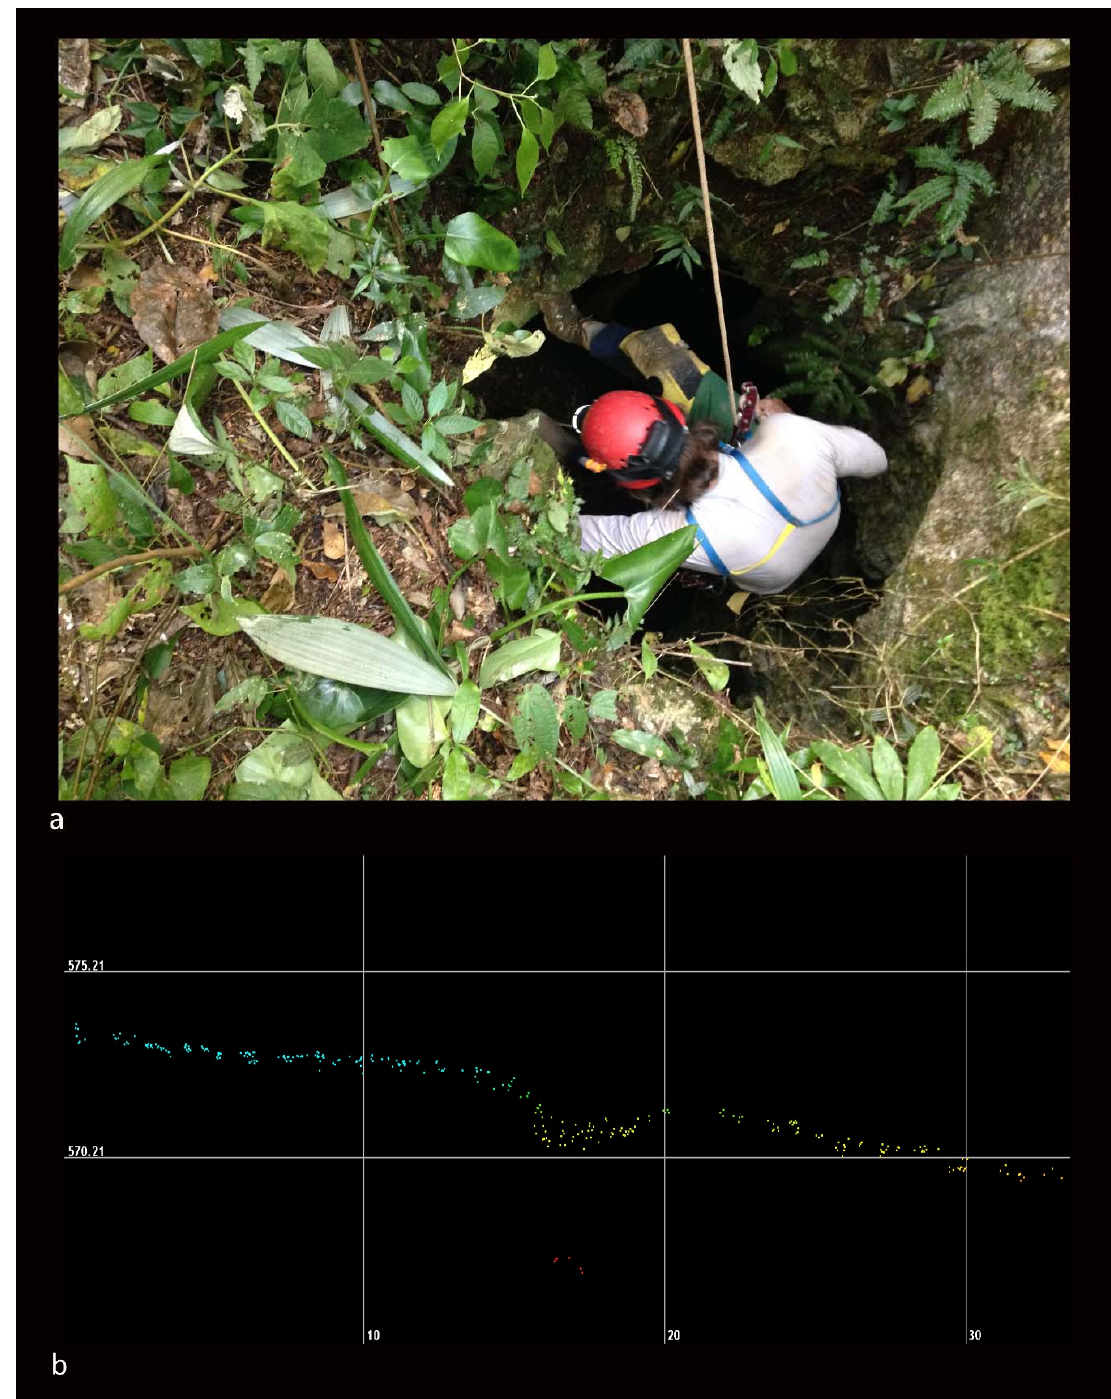
Figure 11. Photo of small shaft opening ( a ). (Matt Oliphant pictured in opening (top), Photo courtesy of LCAR), ( b ) and lidar point cloud in profile using LP360.